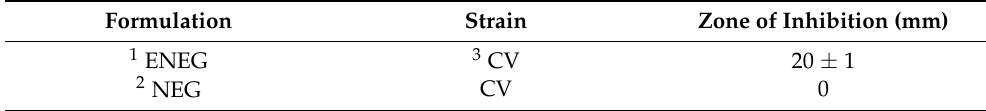
Table 7. Antiquorum sensing activity of essential oil loaded emulsion and emulgel.